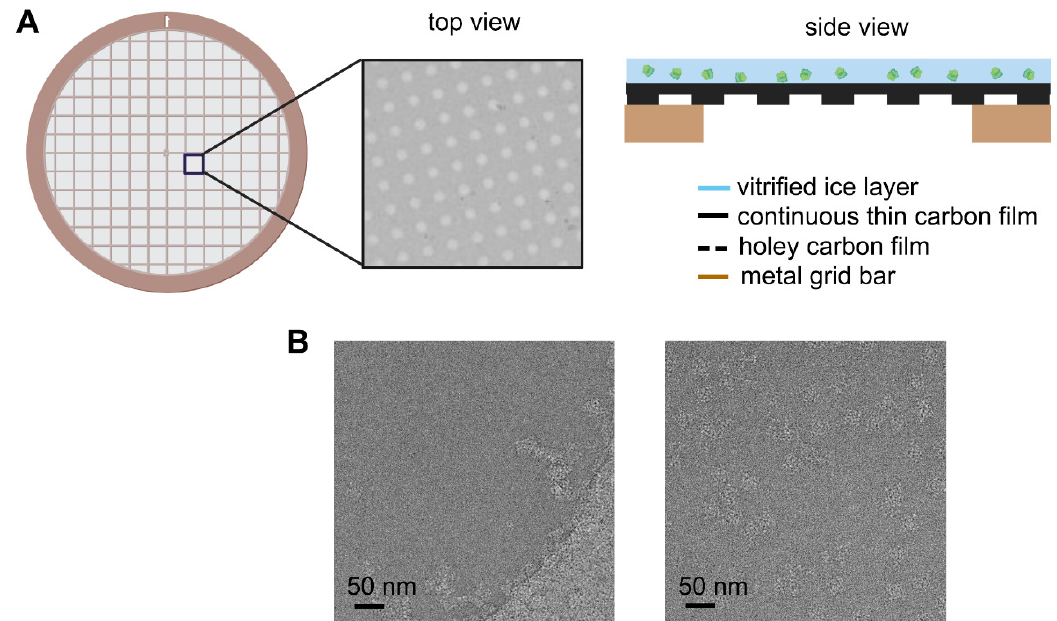
Figure 1. Schematic diagram of improved EM grid and its improvement on the particle distribution. ( A ) Commonly used arrayed EM grid covered with additional layer of continuous thin carbon film on the holey carbon film. ( B ) Example of ryanodine receptor 1 (RyR1) distribution in the vitrified ice without (left panel) and with (right panel) continuous thin carbon film spanning on the hole.